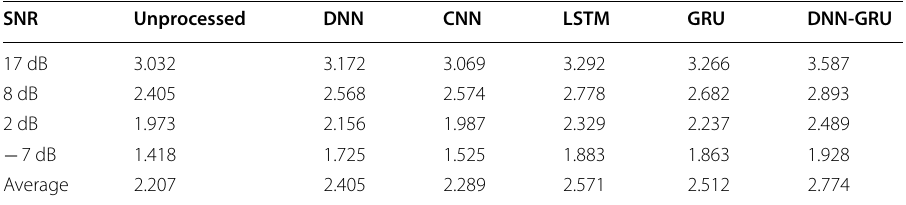
Table 3 Average PESQ results among five models under mismatch input SNRs SNR